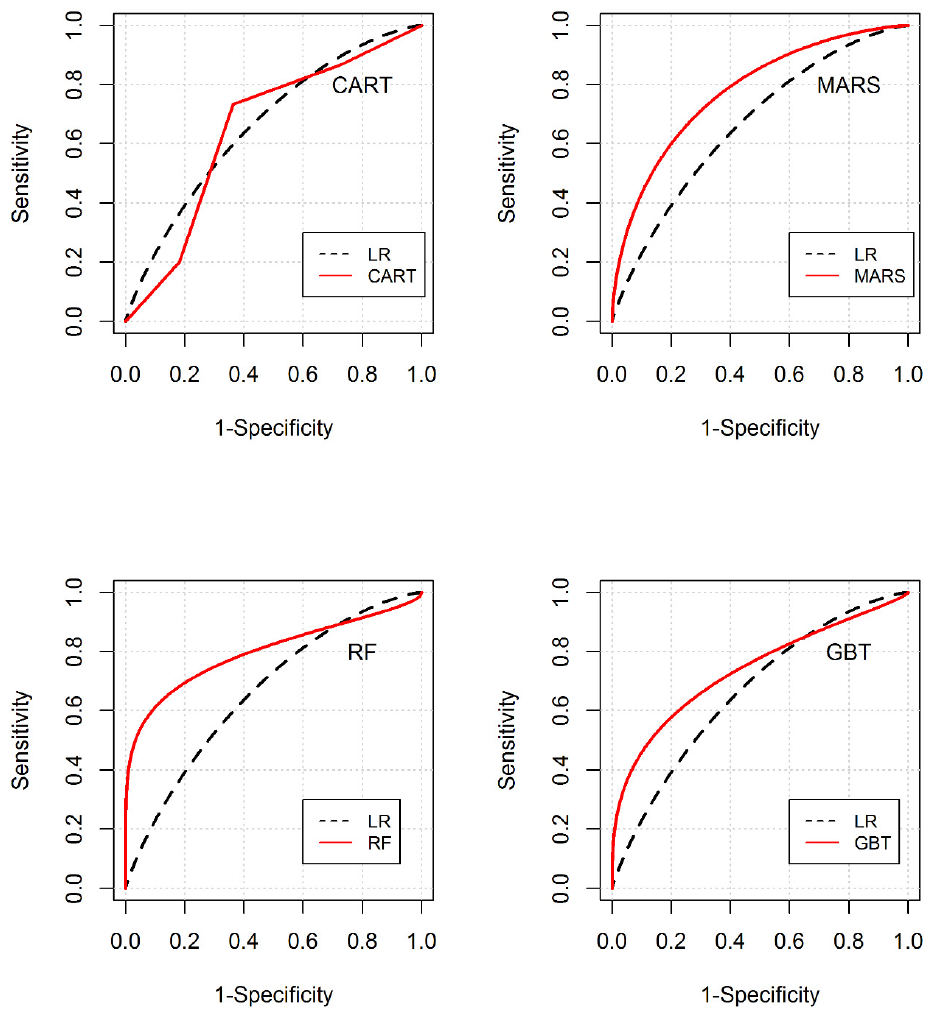
Figure 9. Receiver Operating Characteristics (ROC) Curves for Tree-Based Models in Comparison to the LR model.